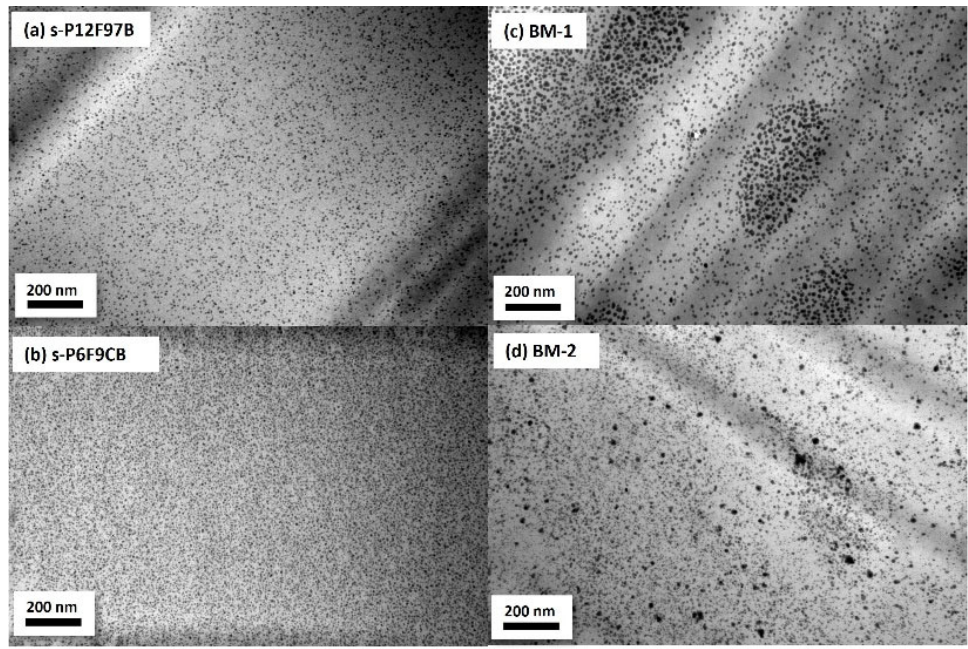
Figure 6. TEM image of the BM-X membranes. To identify the distribution and shape of the ionic cluster morphologies, the blend membranes were subjected to SAXS analysis (Figure 7). The characteristic separation lengths d of these ionomers were calculated and included in Figure 7, where d was the distance between the ion-rich domains in the hydrophobic polymer-rich domains of the ionomer [50,69,70]. BM-1 and BM-2 exhibited maximum contrast intensity ( q max values at 0.52 and 0.44 nm − 1 , respectively; also ionomer peaks) [50,69,70]. The division of BM-X membranes occurred in the high-q-value direction of shoulder-like hillside, which differs from the Gaussian distribution peak pattern exhibited by the guest polymer with a high torsional angle of its cardo structure. As expected, BM-1 shows a similar distribution to BM-2; however, the distribution of BM-1 was closer to that of the host matrix (s-P12F97B: q max = 0.23 Å − 1 and d = 2.92 nm) than to that of BM-2. BM-1 and BM-2 had intercluster distances d of 2.89 and 2.72 nm, respectively. These values are similar to that obtained for the reference (average d of approximately 2.4 nm) [50]. The presence of a cardo